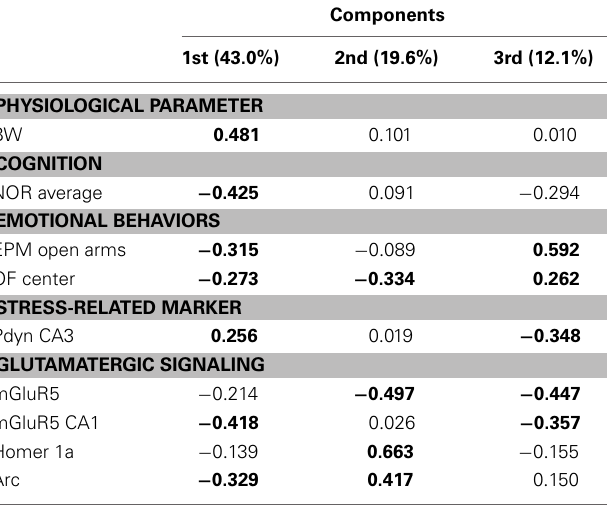
Table 1 | Major contributions to the overall variance on the first, second, and third principal components resulting from the principal component analysis (PCA, Figures 9F,G) applied to old and very old male and female LOU rats ( n = 6) and old SD rats ( n = 6) with IHC